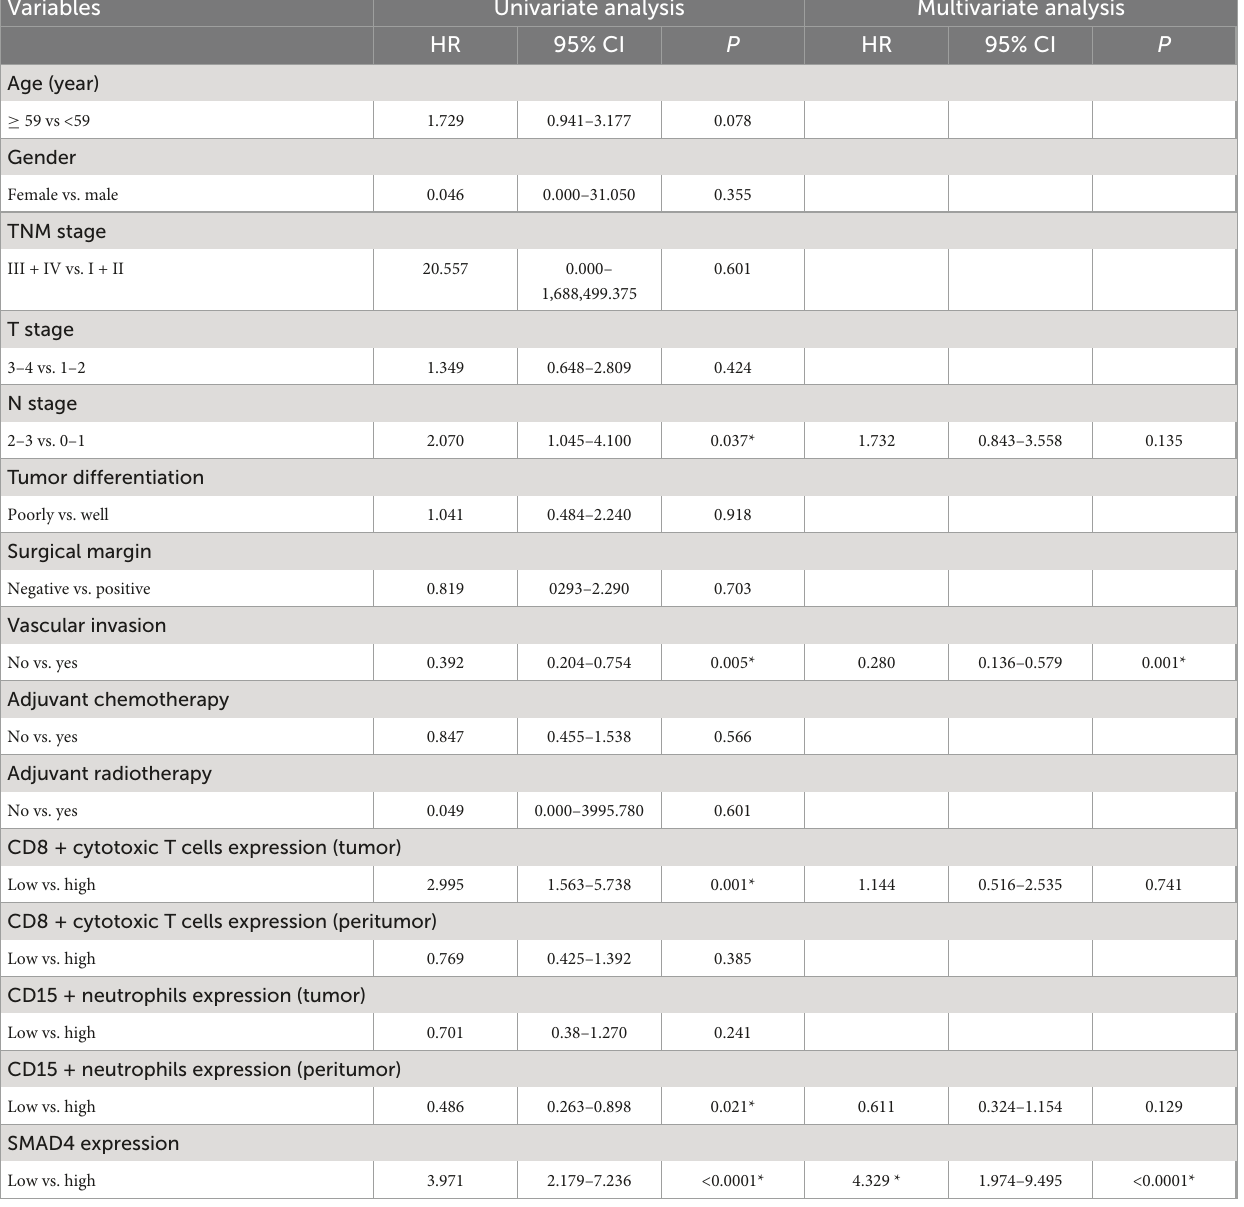
TABLE 3 Univariate and multivariate analyses of variables associated with disease-free survival.